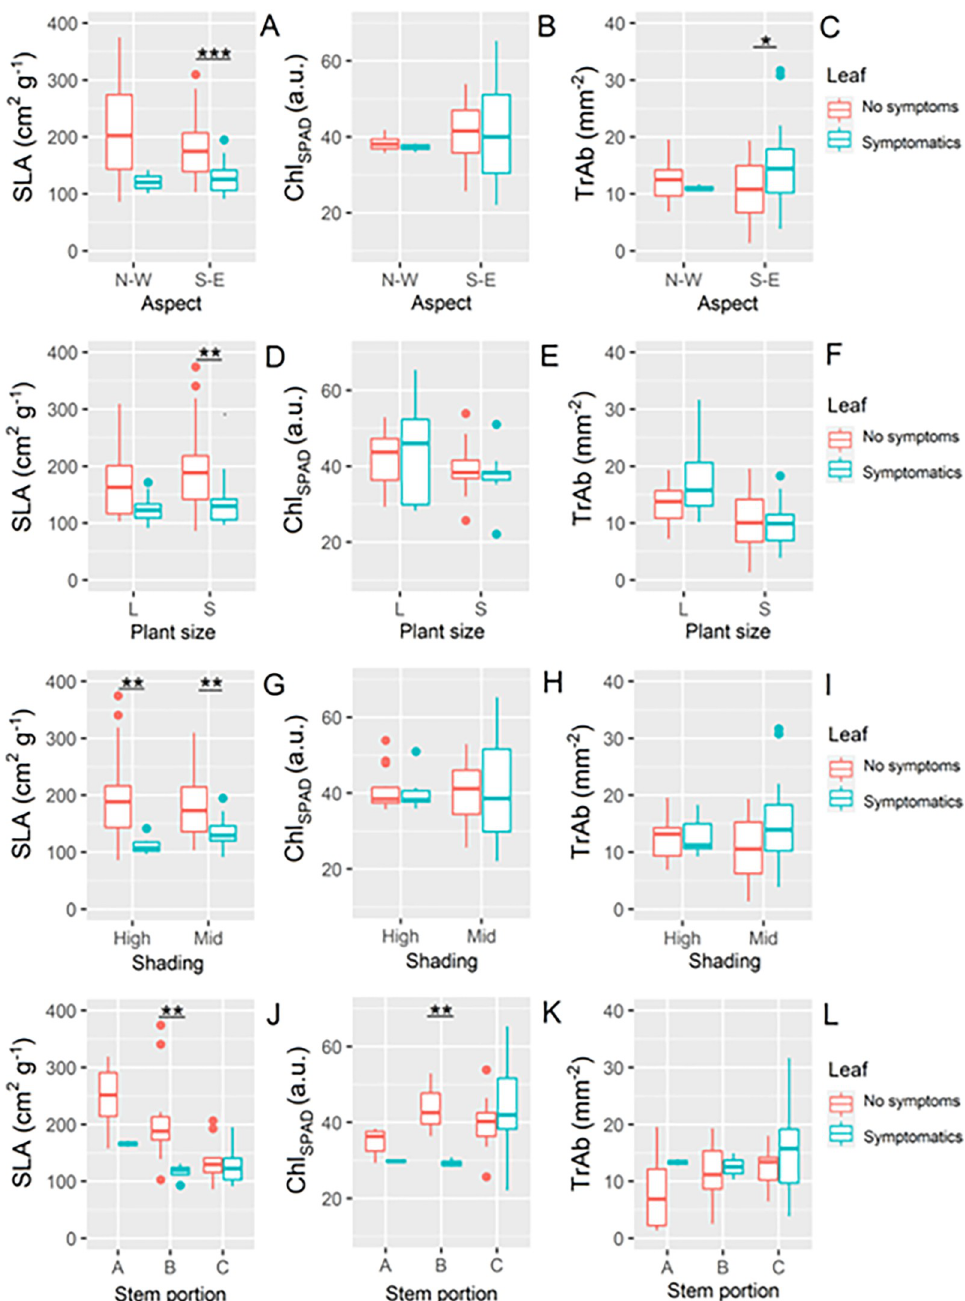
Fig 6. Comparison between the values of A) specific leaf area (SLA), B) chlorophyll content (Chl SPAD ) and C) abaxial trichome density (TrAb) of symptomatic and non-symptomatic leaves of symptomatic plants, sorted for aspect, shading and stem portion categories. The results of Mann-Whitney U test are reported: ��� p < 0.001, �� p < 0.01, � <